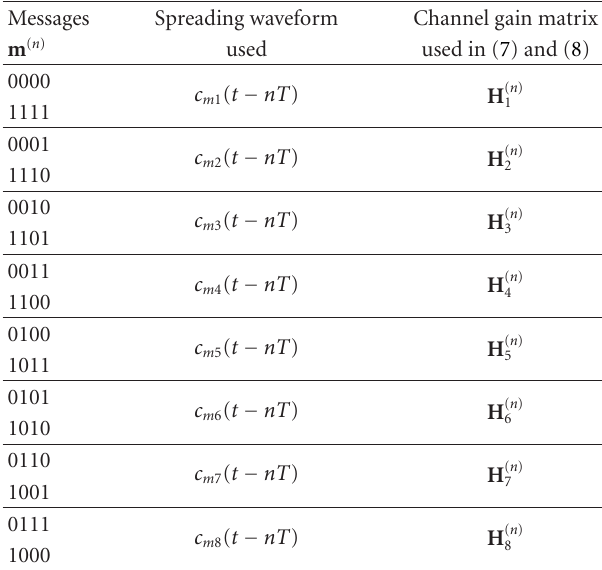
Table 1: The allocation of spreading waveforms in parity bit se- lected spreading technique for N t =